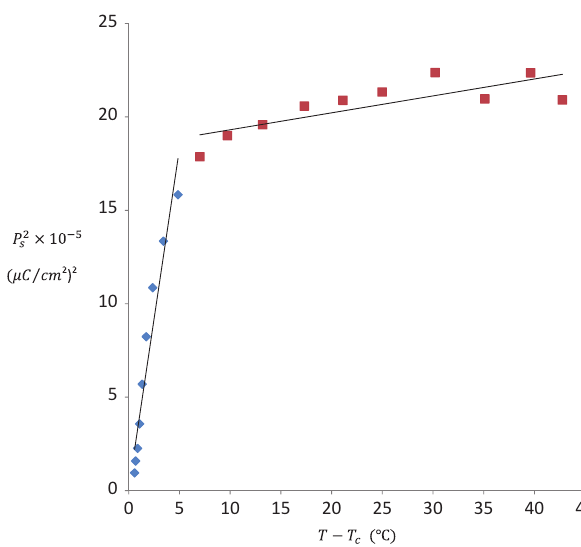
Figure 3: Spontaneous polarization squared ( P 2 s Þ as a function of T − T c using the experimental data along the c direction at 100kHz [1]. Solid lines represent the best fit to the experimental data [1] according to eq. (14) for the temperature intervals indicated for TMAHSO 4 (See Table